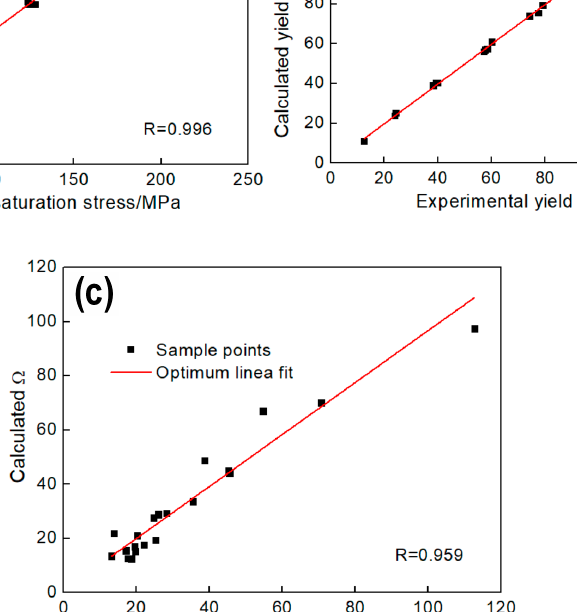
σ , ( b ) σ , ( c ) Ω . sat 0